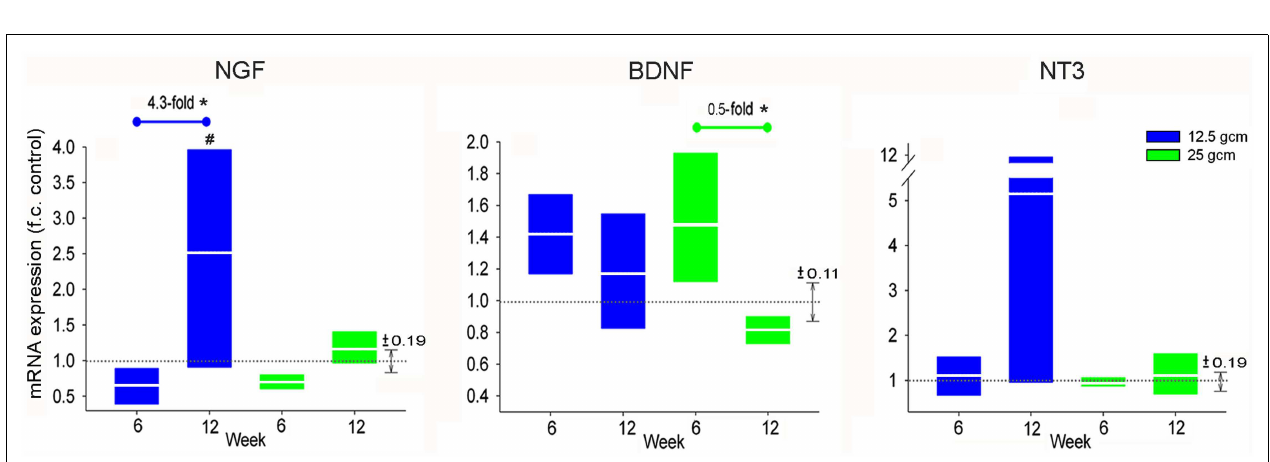
X axis denotes weeks post injury.White lines in box-plots indicate group mean. Dotted gray lines indicate expression level of controls (normalized to 1), with ± SEM indicated by the vertical arrows at right end of the control line. # p < 0.05 from control. * p < 0.05, ** p < 0.01, *** p <